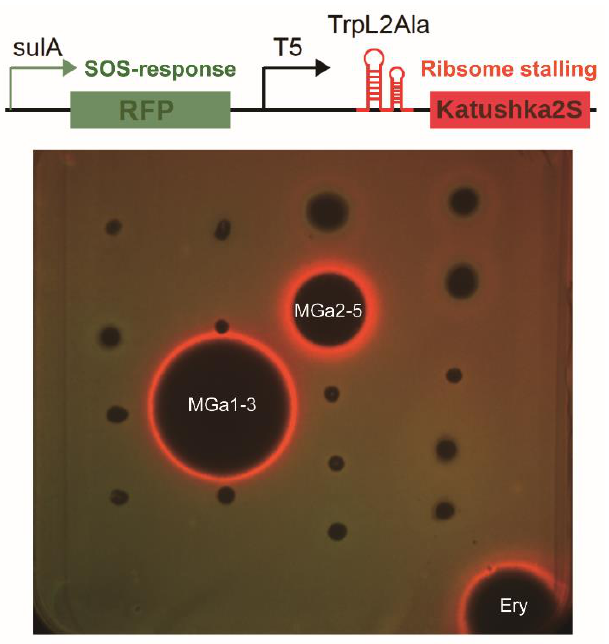
Figure 4. The dual-fluorescent reporter “pDualrep2” system sensitive to inhibitors of ribosome progression or DNA replication. Spots of erythromycin (Ery) and test samples were placed on an agar plate coated with a layer of E. coli JW5503 Δ tolC strain that was transformed with the pDualrep2 plasmid. Induction of the expression of Katushka2S is triggered by translation inhibitors, whereas RFP expression occurs on DNA-damage induced SOS-response. The plate was scanned under the ChemiDoc Imaging System at 553/574 nm and 588/633 nm channels to detect RFP (green pseudocolor) and Katushka2S (red pseudocolor) fluorescence, respectively.